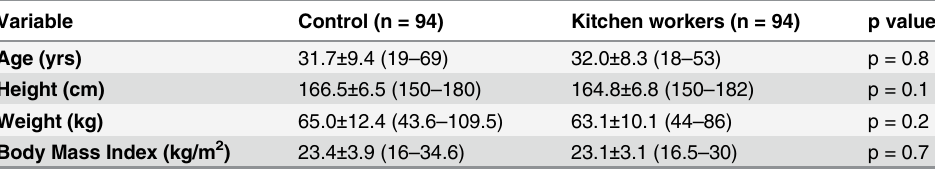
Table 1. Physical characteristics of kitchen workers and